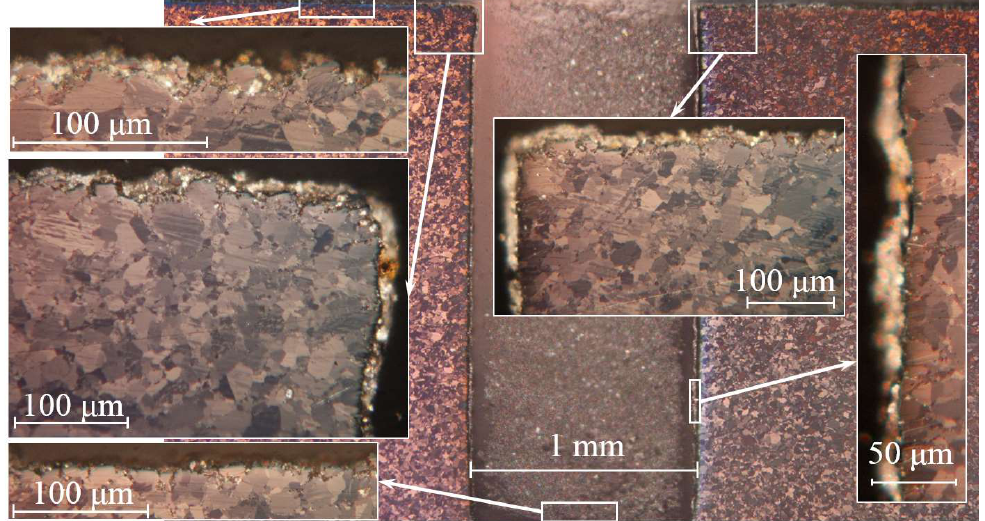
Figure 10. Microstructure of the Be-5 sample cross section (800 °С, 100 cycles).